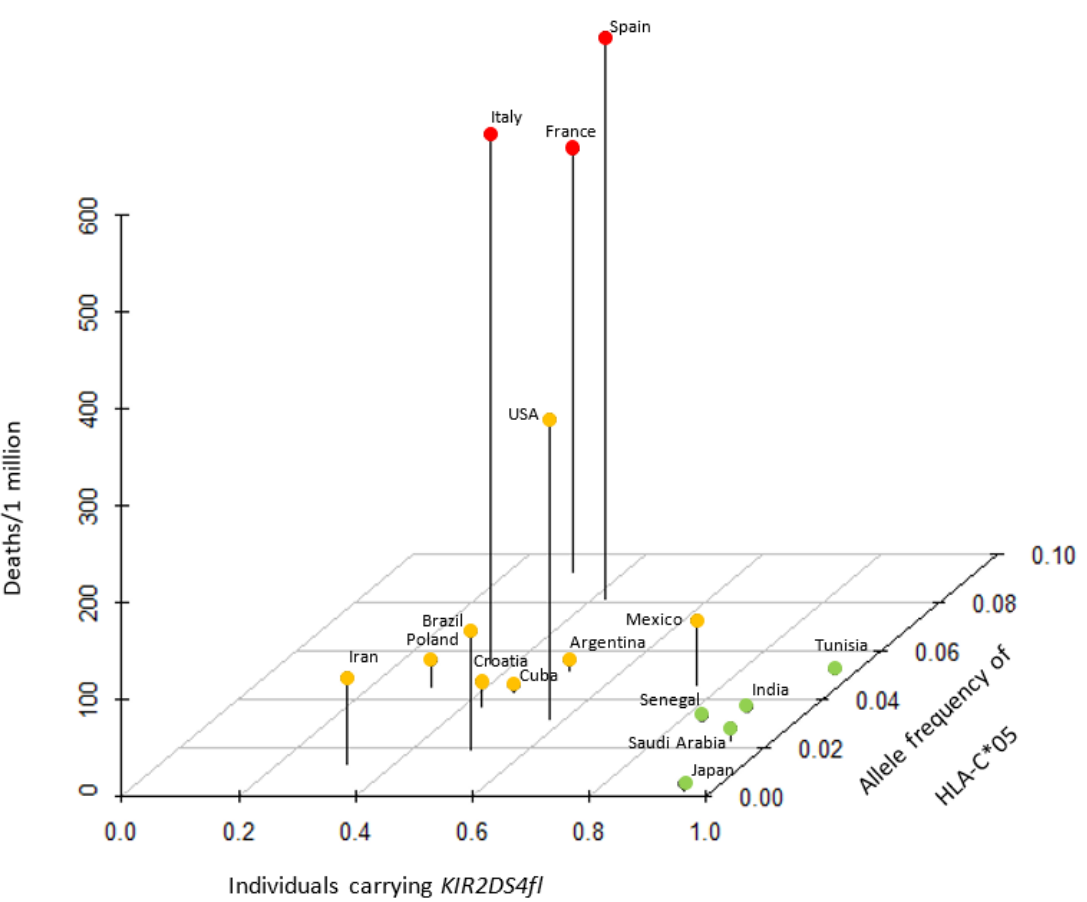
Figure 2. Association between allele frequency of HLA-C*05, proportion of individuals carrying KIR2DS4fl and risk of deaths due to COVID-19. Countries with high, medium and low mortality could be categorized into three distinct groups with a specific pattern of HLA-C*05/ KIR2DS4fl expression. KIR: killer cell immunoglobulin-like receptor.